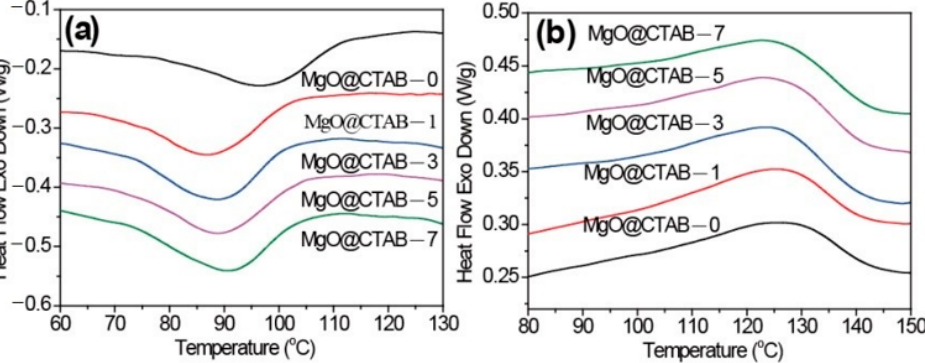
Figure 4. Differential scanning calorimetry (DSC) thermograms of PBAT/MgO@CTAB nano- composites. ( a ) First cooling, ( b ) second heating. ( b ) second heating. Table 1. DSC thermograms of PBAT and its